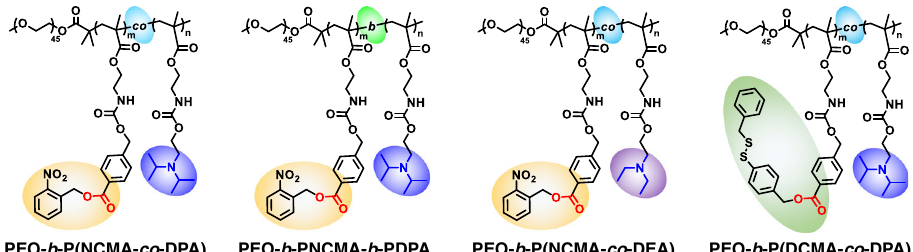
Fig. 2 Chemical structures of four types of amphiphilic block copolymers (BCPs) used in